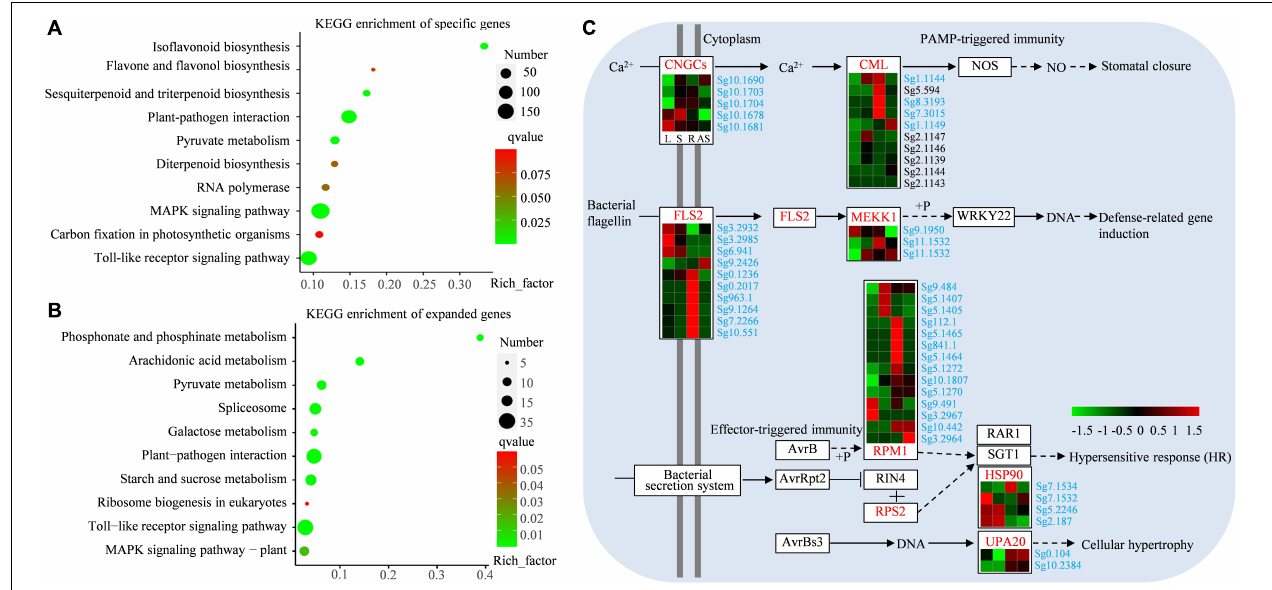
FIGURE 5 | KEGG enrichment and expression analysis of specific and expanded genes in S. glabra genome. (A) KEGG enrichment analysis of S. glabra- specific genes. (B) KEGG enrichment analysis of S. glabra- expanded genes. (C) Expression patterns of specific and expanded genes involved in the plant–pathogen interaction pathway in S. glabra . The specific and expanded genes were marked in blue and black,